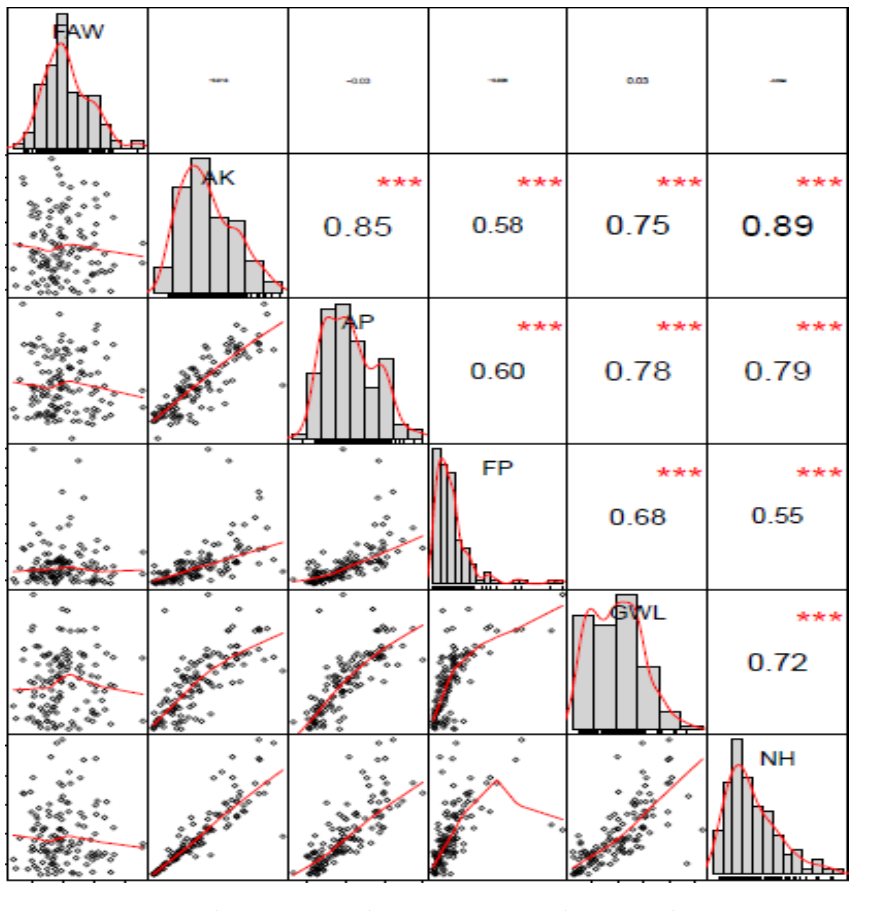
Figure 1. Pairwise Pearson phenotypic correlation among FAW damage and MW traits. AK = number of affected kernels, NH = number grain holes, AP = number of emerged adult progenies, FAW = Fall armyworm, FP = total amount of flour produced, and GWL = grain weight loss.